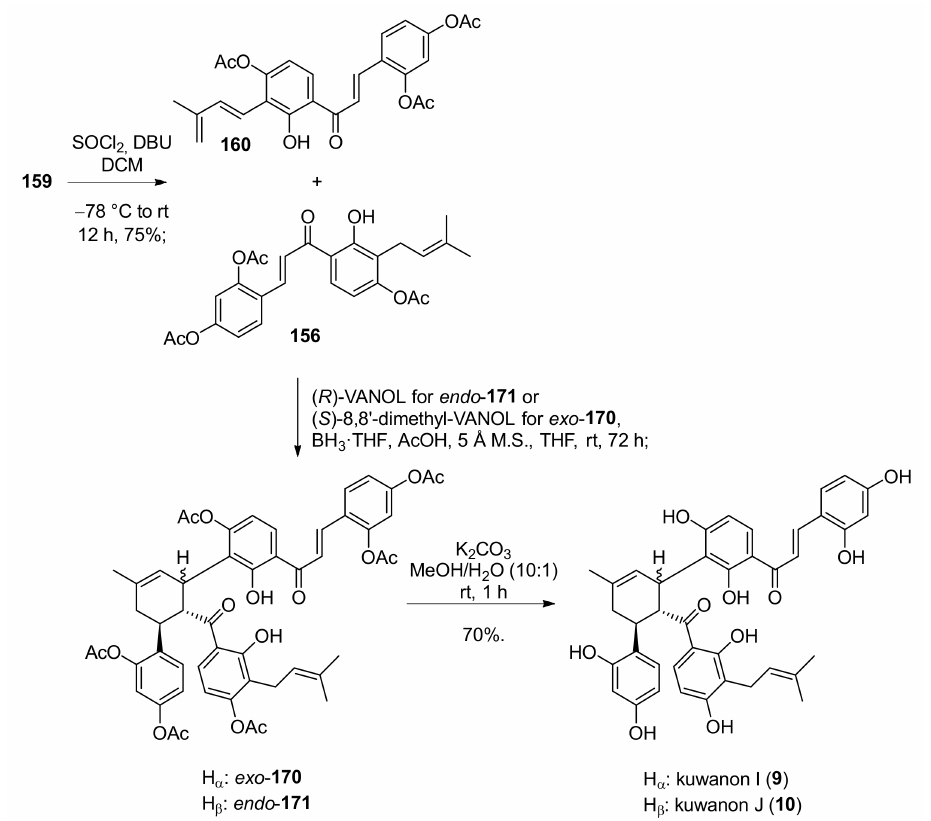
Figure 57. Enantioselective Diels–Alder cycloaddition towards kuwanons I and J ( 9 and 10